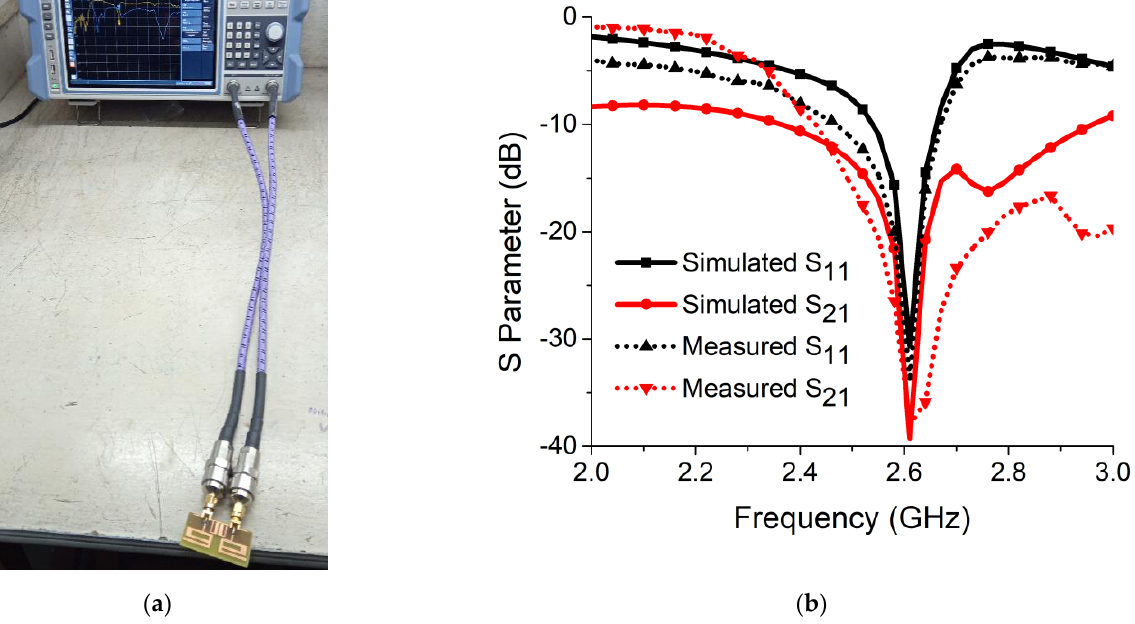
Figure 15. ( a ) Measurement setup of vector network analyzer (VNA); ( b ) simulated and measured results of resonance and isolation.